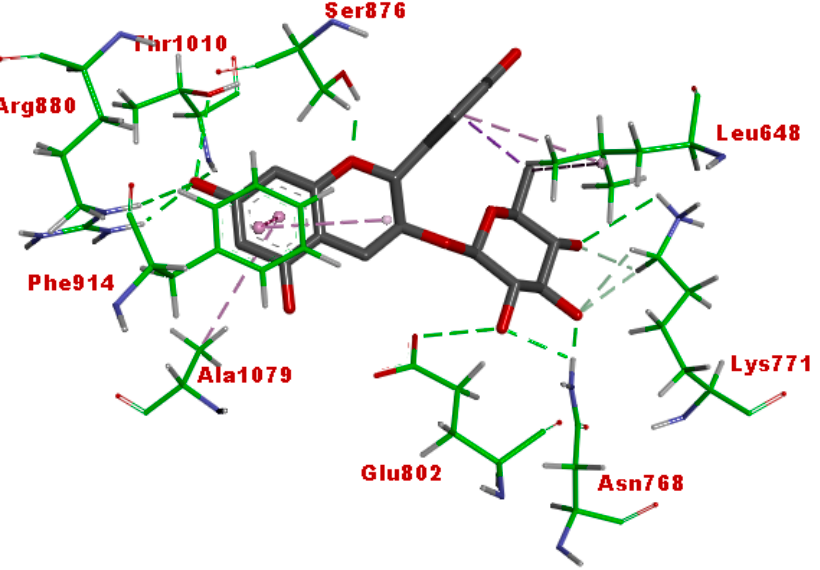
Figure 9. Binding interaction of afzelechin 3- O -alpha- L -rhamnoside with the active site residues of xanthine oxidase (PDB code: 3NVY). Green and purple dashes represent hydrogen-bonding and hydrophobic interactions, respectively.